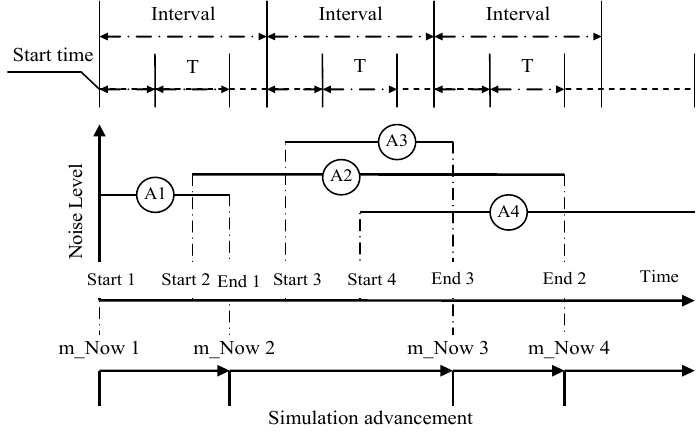
Figure 4. Illustration of each period of time T for calculating L eq-T along with simulation advancement